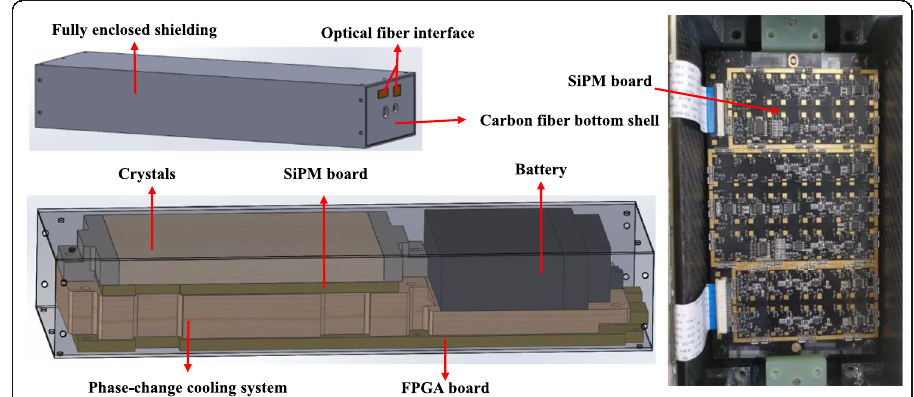
Fig. 1 Mechanical structure of one detector module (left) and real picture of SiPM board